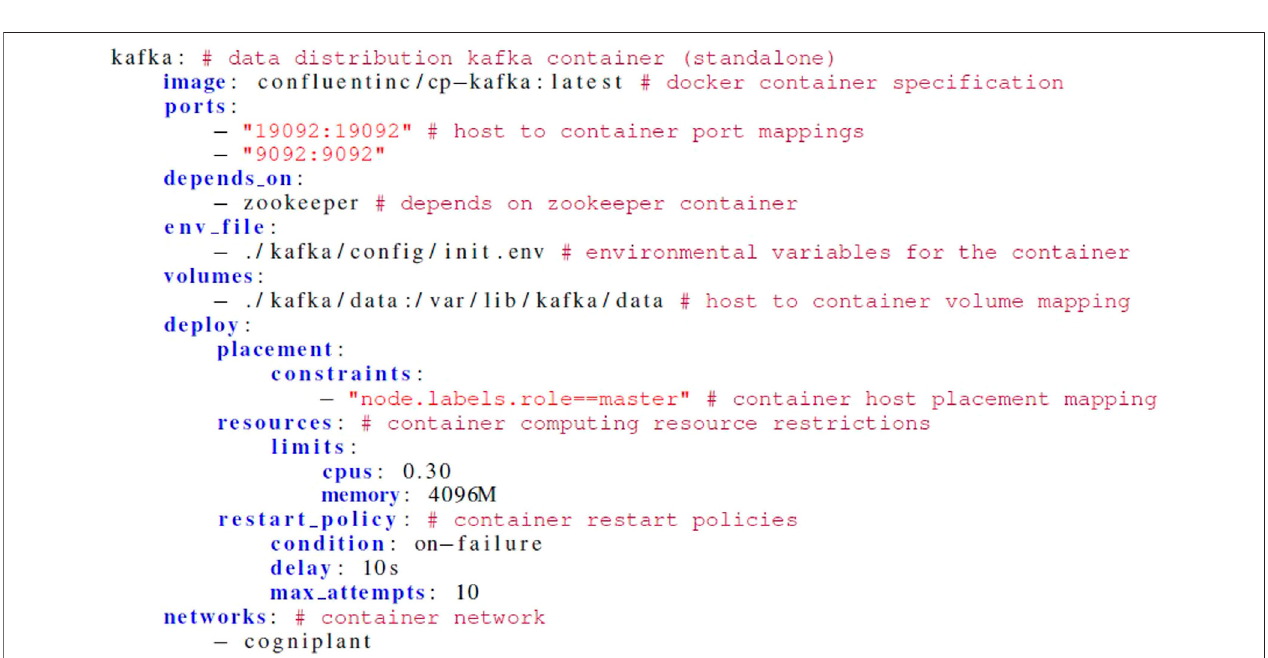
FIGURE 3 | Example docker-compose service de fi nition for standalone Kafka